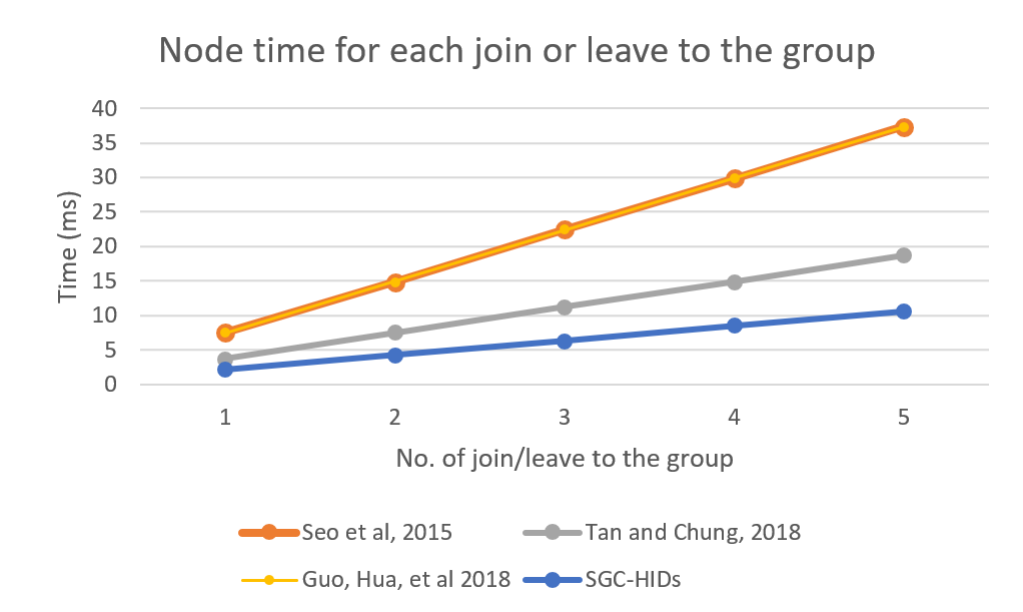
Figure 14. Each group nodes computation time needed for each join or leave to the